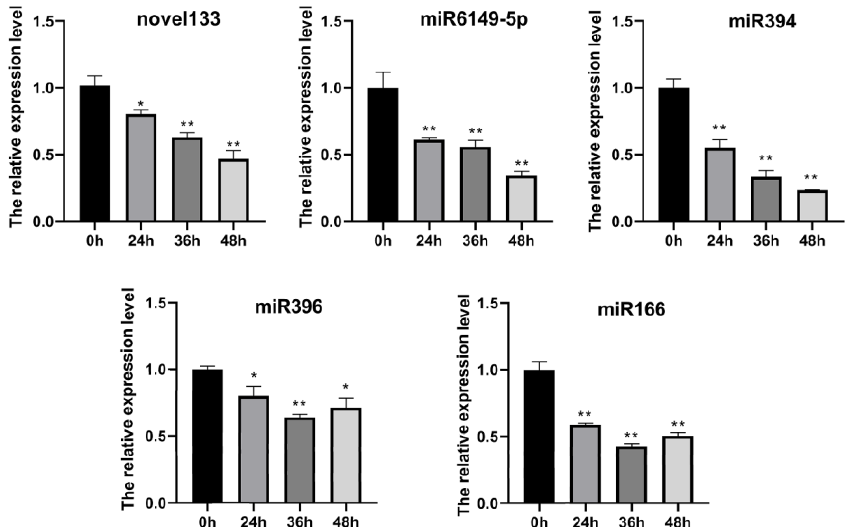
Figure 3. Real-time quantitative PCR validation of 5 miRNAs during P. infestans infection three time courses. miRNA expression level was analyzed by the 2 − △△ CT method utilizing U6 as the reference gene. One-way ANOVA, * , p < 0.05, **, p < 0.01. Three potato leaves were pooled into one biological replicate at each P. infestans inoculation time point. Error bars represent mean ± SD of three biological replicates.